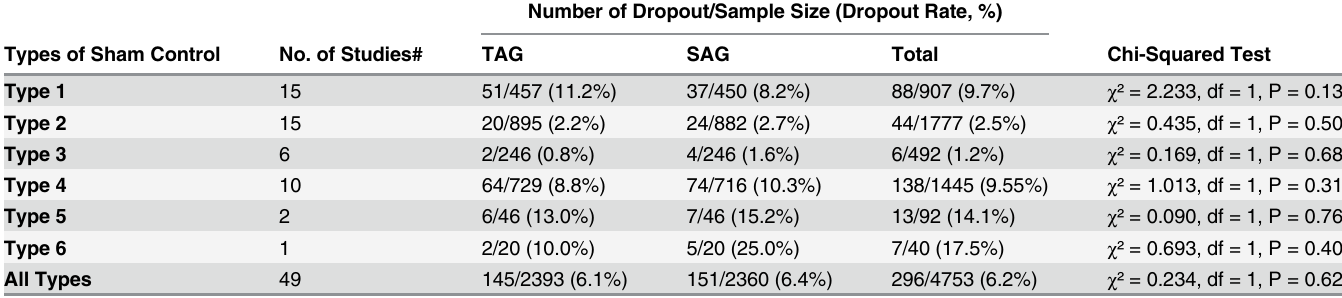
Table 7. Summary of Dropout Rate Reported in the Included Studies. Number of Dropout/Sample Size (Dropout Rate,